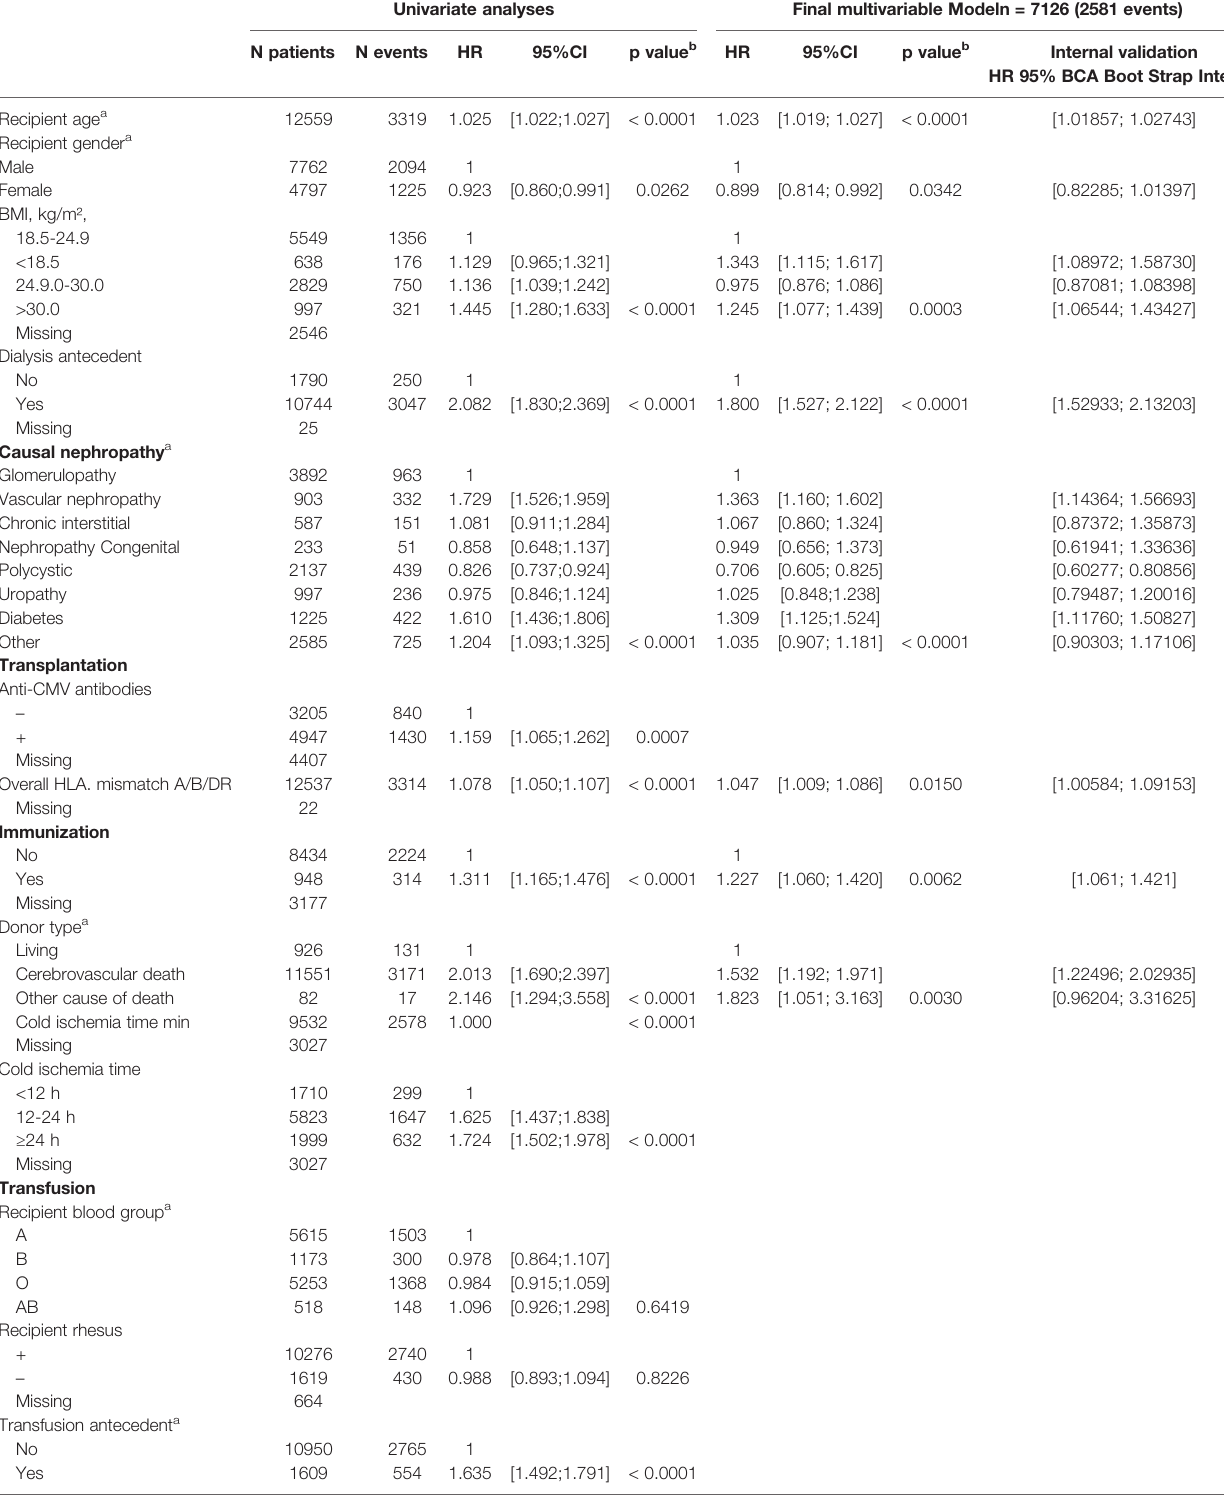
TABLE 2 | Factors associated with transplant